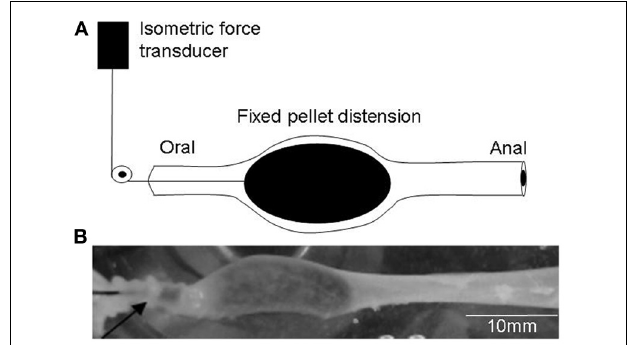
FIGURE 1 | Schematic representation of the method used to evoke repetitive peristaltic contractions. (A) An artificial fecal pellet is inserted into the oral end of the isolated colon attached to fine cotton thread. The pellet was allowed to naturally propel along the colon, until it reached a point midway along the colon where it was fixed and isometric force measurements made of the degree of tension generated on the pellet, during each cyclical peristaltic contraction. (B) Shows a photomicrograph of the pellet fixed in the colonic lumen. The arrow indicates a robust circular muscle contraction active on the oral side of the